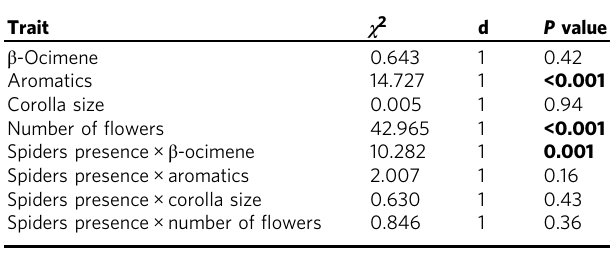
Table 1 Effect of fl oral traits and of the interactions between fl oral traits and crab spider presence on the attractiveness of fl owers to bees (crab spiders hunting on 25 – 33% of the plants or no spiders present, generalized mixed model, N = 108 per treatment)